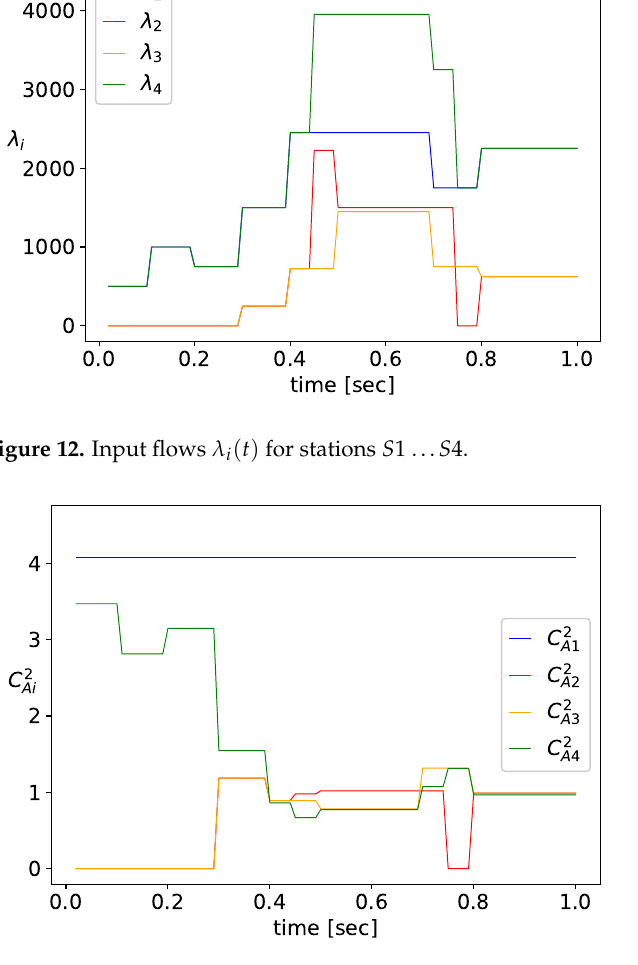
Figure 13. Squared coefficients of variation C 2